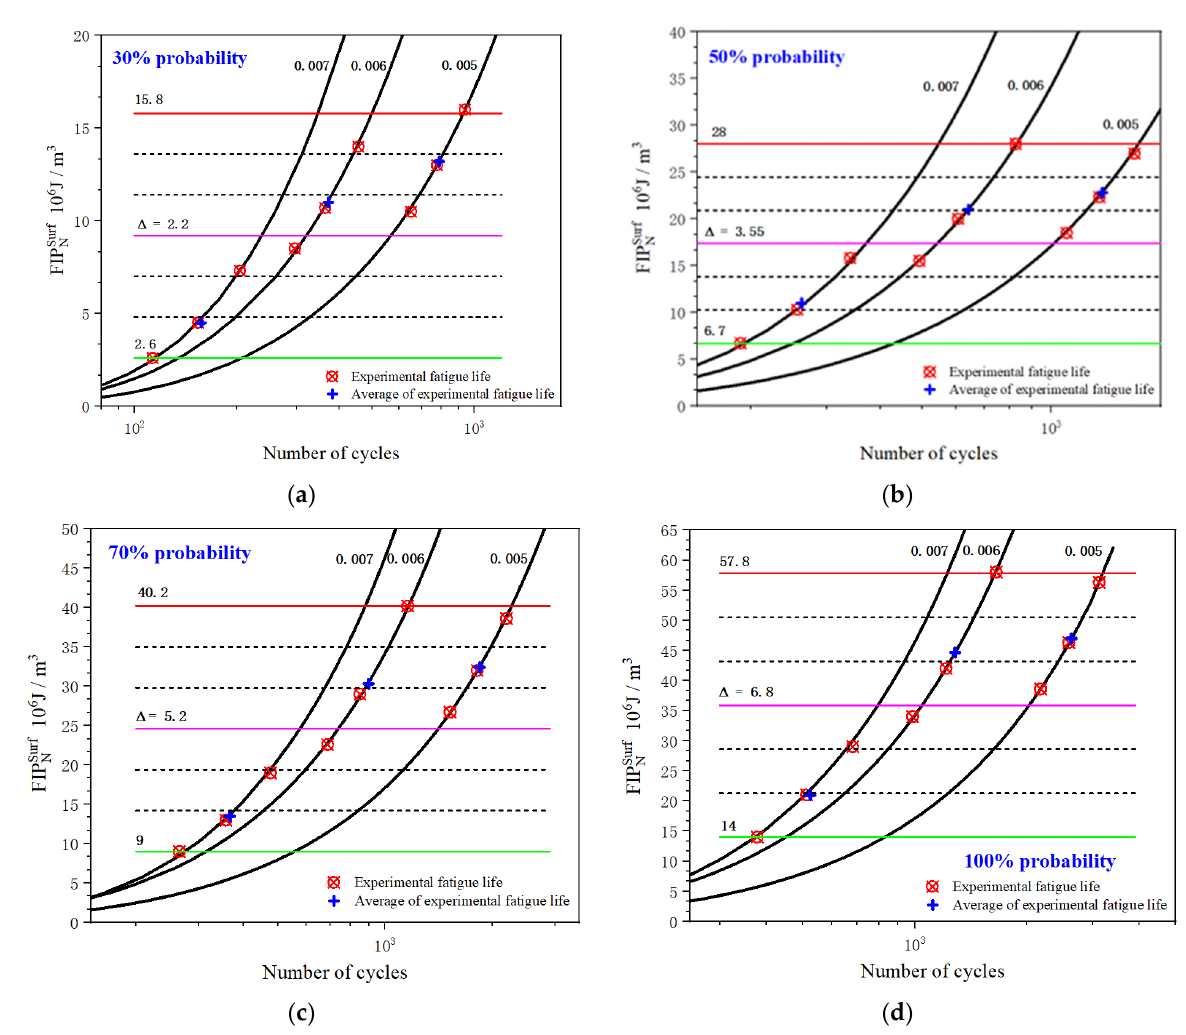
Surf FIP under different probabilities. Figure 13. The evolution of Figure 13. The evolution of FIP Surf under different probabilities. N N Table 4. Nucleation life prediction for various FIP Surf with respect to their different probabilities. Table 4. Nucleation life prediction for various with respect to their different probabilities. N 50%